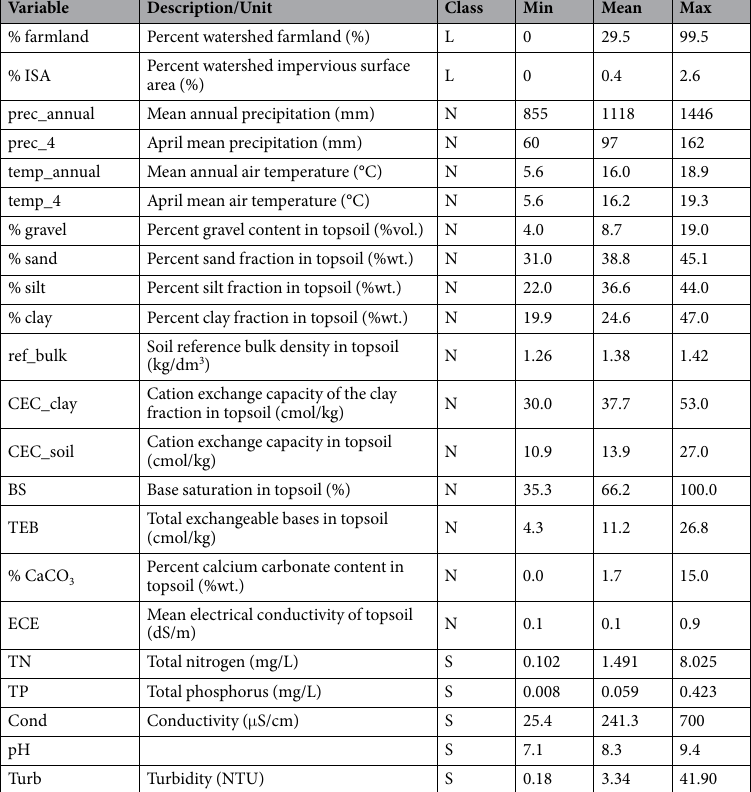
Table 1. Description and statistics of variables measured for the study sites located in tributaries of the Three Gorges Reservoir. Variables were categorized into three classes: land use variables (L), natural environmental variables (N), and in-stream stressors (S), with the minimum (Min), arithmetic mean (Mean), and maximum (Max) presented. (%vol.: volume percentage; %wt.: weight